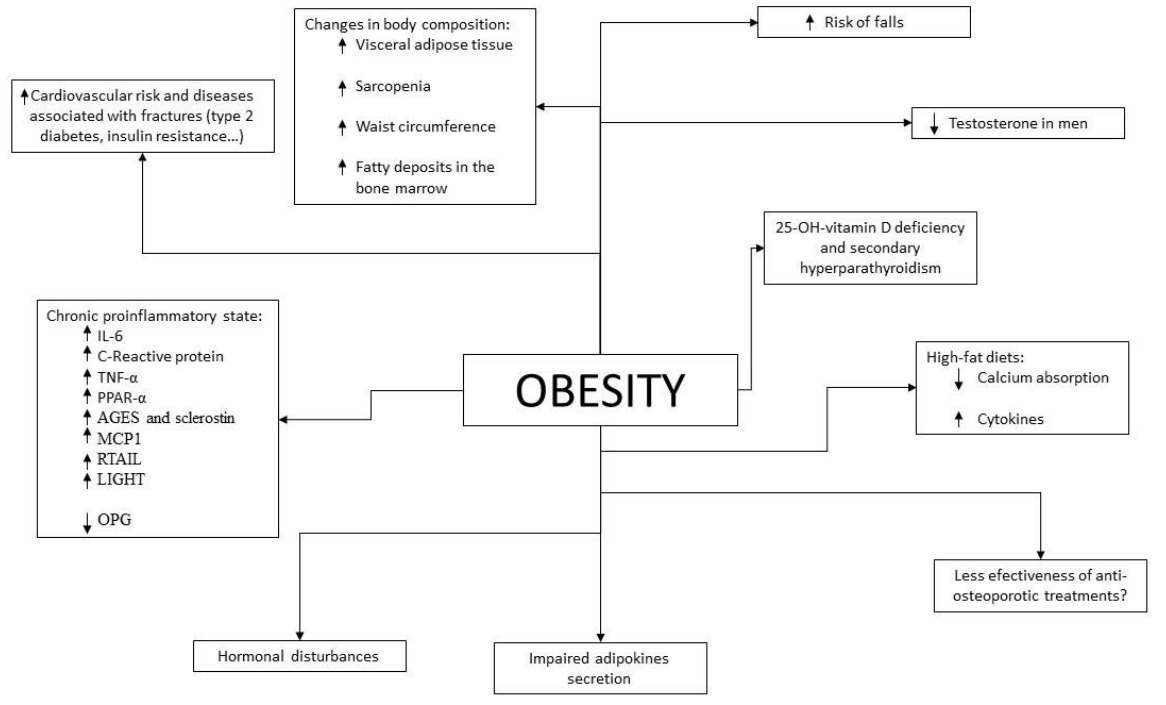
Figure 1. Pathophysiological mechanisms that relate obesity to bone health. Arrows indicate increase or decrease levels.